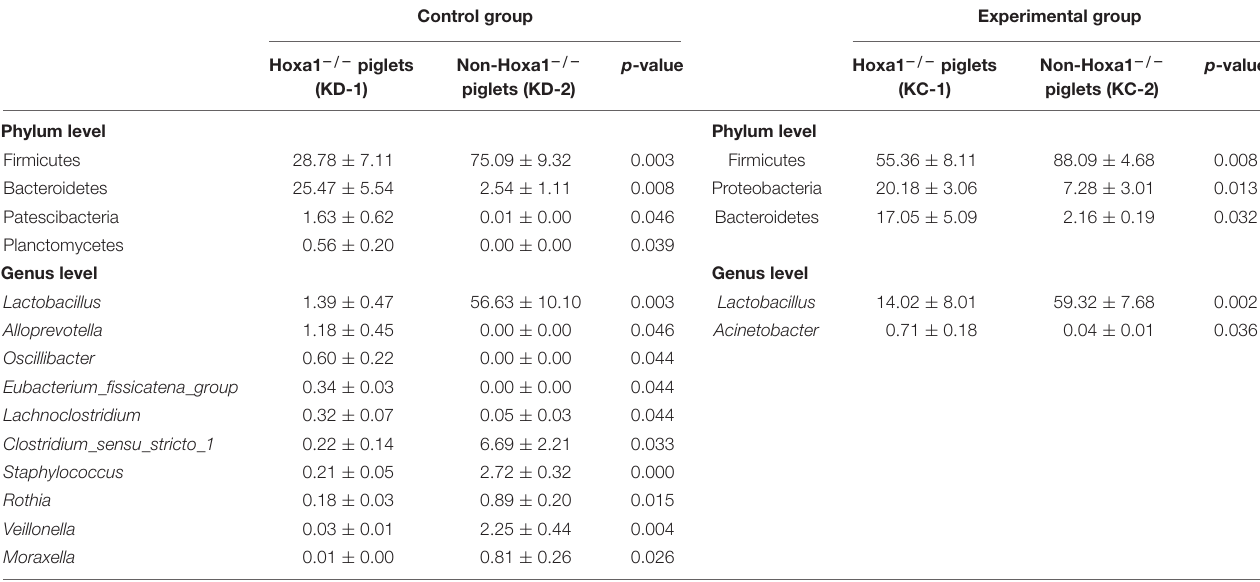
TABLE 3 | The differential jejunal bacterial community of newborn piglets between different genotypes within the same treatment group (%).